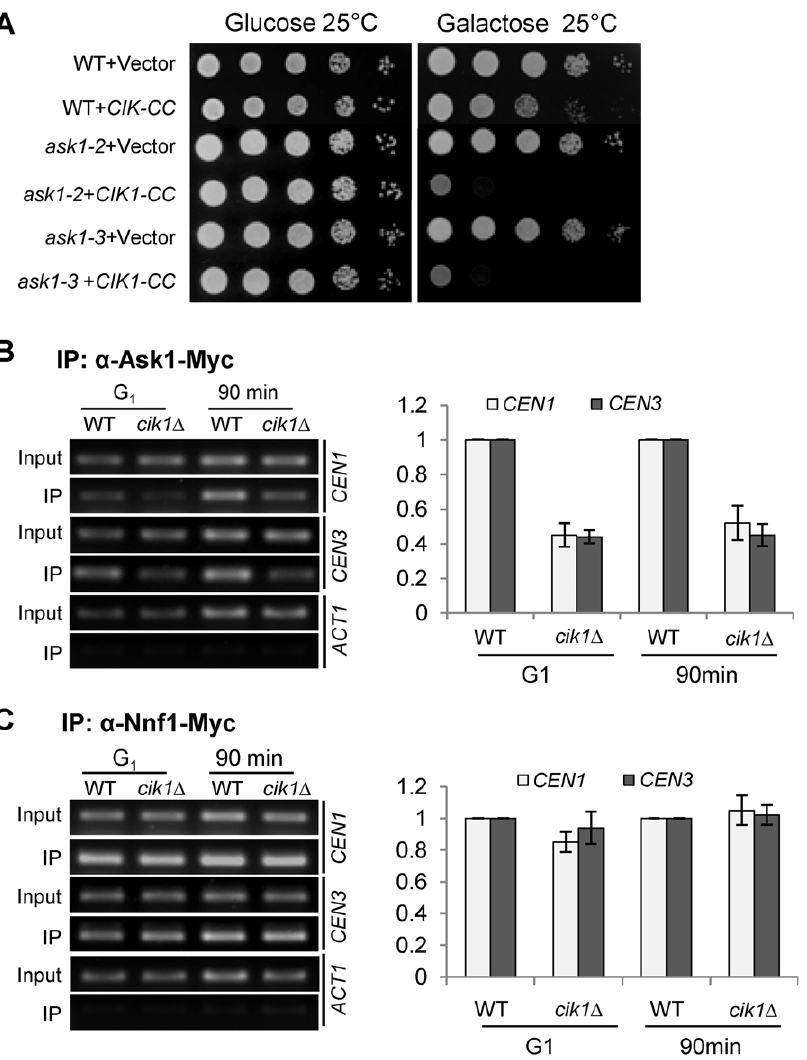
Figure 7. Dysfunctional Cik1/Kar3 leads to decreased DASH–kinetochore interaction. A. Overexpression of CIK1-CC is lethal to ask1 mutants. Saturated cell cultures with indicated genotypes were 10-fold diluted and then spotted onto dropout plates containing glucose or galactose. B. cik1 D mutant cells show decreased centromere association of Ask1. G 1 -arrested cdc13-1 ASK1-9myc and cdc13-1 cik1 D ASK1-9myc were released to YPD medium at 34 u C. The cells were collected at time 0 and 90 min for ChIP assay with anti-myc antibody. The PCR products with primers specific for CEN1 , CEN3 , and ACT1 are shown in the left panel and the quantified data are shown in the right. The ratio of the PCR yield (IP/input) in WT cells was standardized as one. The experiment was repeated three times. C. cik1 D mutant cells exhibit normal association of Nnf1 with centromeric DNA. cdc13-1 NNF1-13myc and cdc13-1 cik1 D NNF1-13myc cells were treated as in B. The PCR products with primers specific for CEN1 , CEN3 and ACT1 are shown in the left panel and the quantified data are shown in the right. The experiment was repeated for three times.